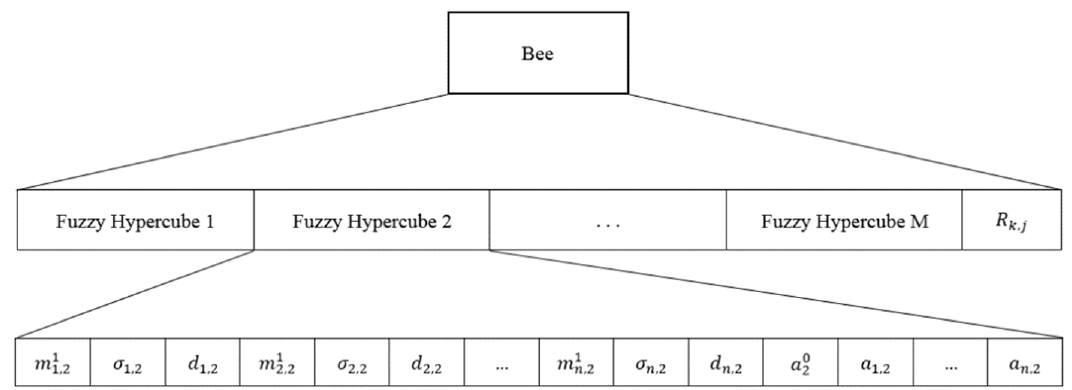
Figure 7. Schematic diagram of individual bee coding.